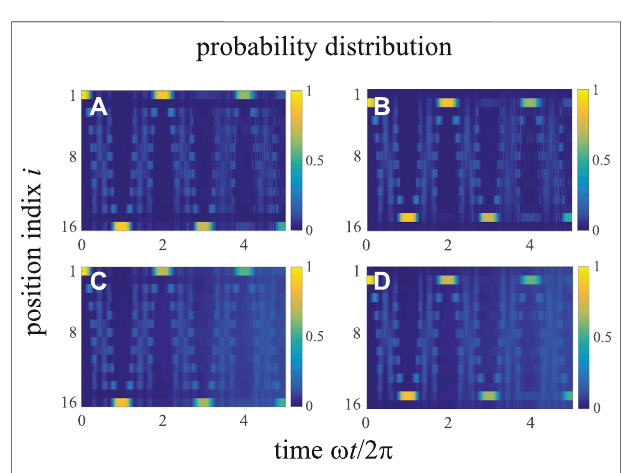
FIGURE 9 | (Color online) Time evolution of the probability distribution of anopenchainfor N (cid:1) 8.Thetimedependentpumpsequenceisde fi nedin Eq. 29 ,with (A,C) z / v (cid:1) 0.1, A / v (cid:1) 1.1, ω / v (cid:1) 2 π /100,and P 1 (0) (cid:1) 1; (B,D) z / v (cid:1) 10, A / v (cid:1) 11, ω / v (cid:1) 2 π /10, and P 2 (0) (cid:1) 1. (A, B) are plotted without disorder; (C) is plotted for the normally distributed disorder ϵ with a standard deviation 0.05 v ; (D) is plotted for the normally distributed disorder ϵ with a standard deviation 0.5 v . The phase factor is ϕ (cid:1)